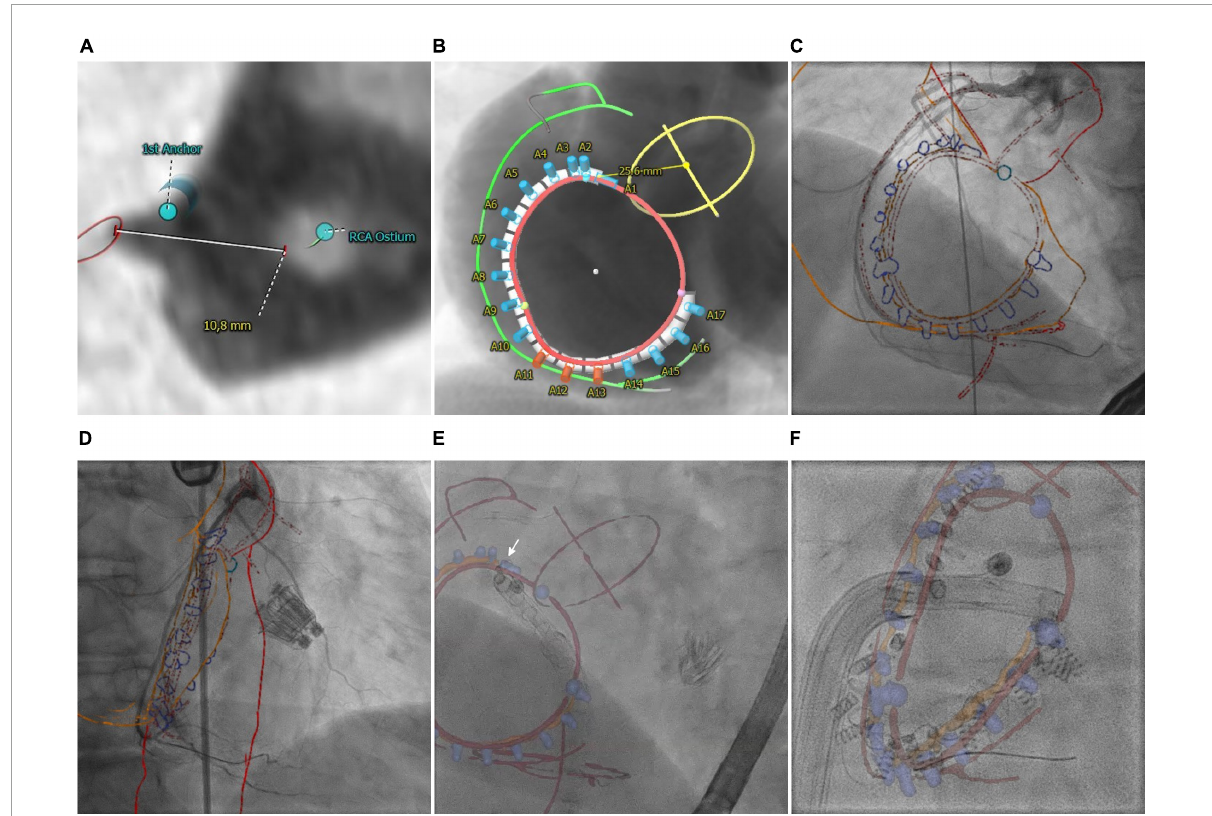
FIGURE2 Transcatheter tricuspid annuloplasty. (A) CTA-derived optimal first anchor position. (B) Patient-specific anchoring is shown in angiographical simulation with marked anatomical landmarks including the right coronary artery (RCA, green), aortic root (AO, yellow), and tricuspid valve annulus (TV, red). (C,D) Manual registration based on angiographies of the RCA. (E) Image fusion of anatomical landmarks (red), trajectory (orange), and anchors (blue cylinders) during implantation of the first anchor (white arrow). The catheter is aligned with the vena cava inferior. (F) Image fusion of the lastly implanted anchor. Anchor heads are aligned with the planned trajectory. The commissures (blue spheres) indicated a potentially higher risk of the catheter slipping off the